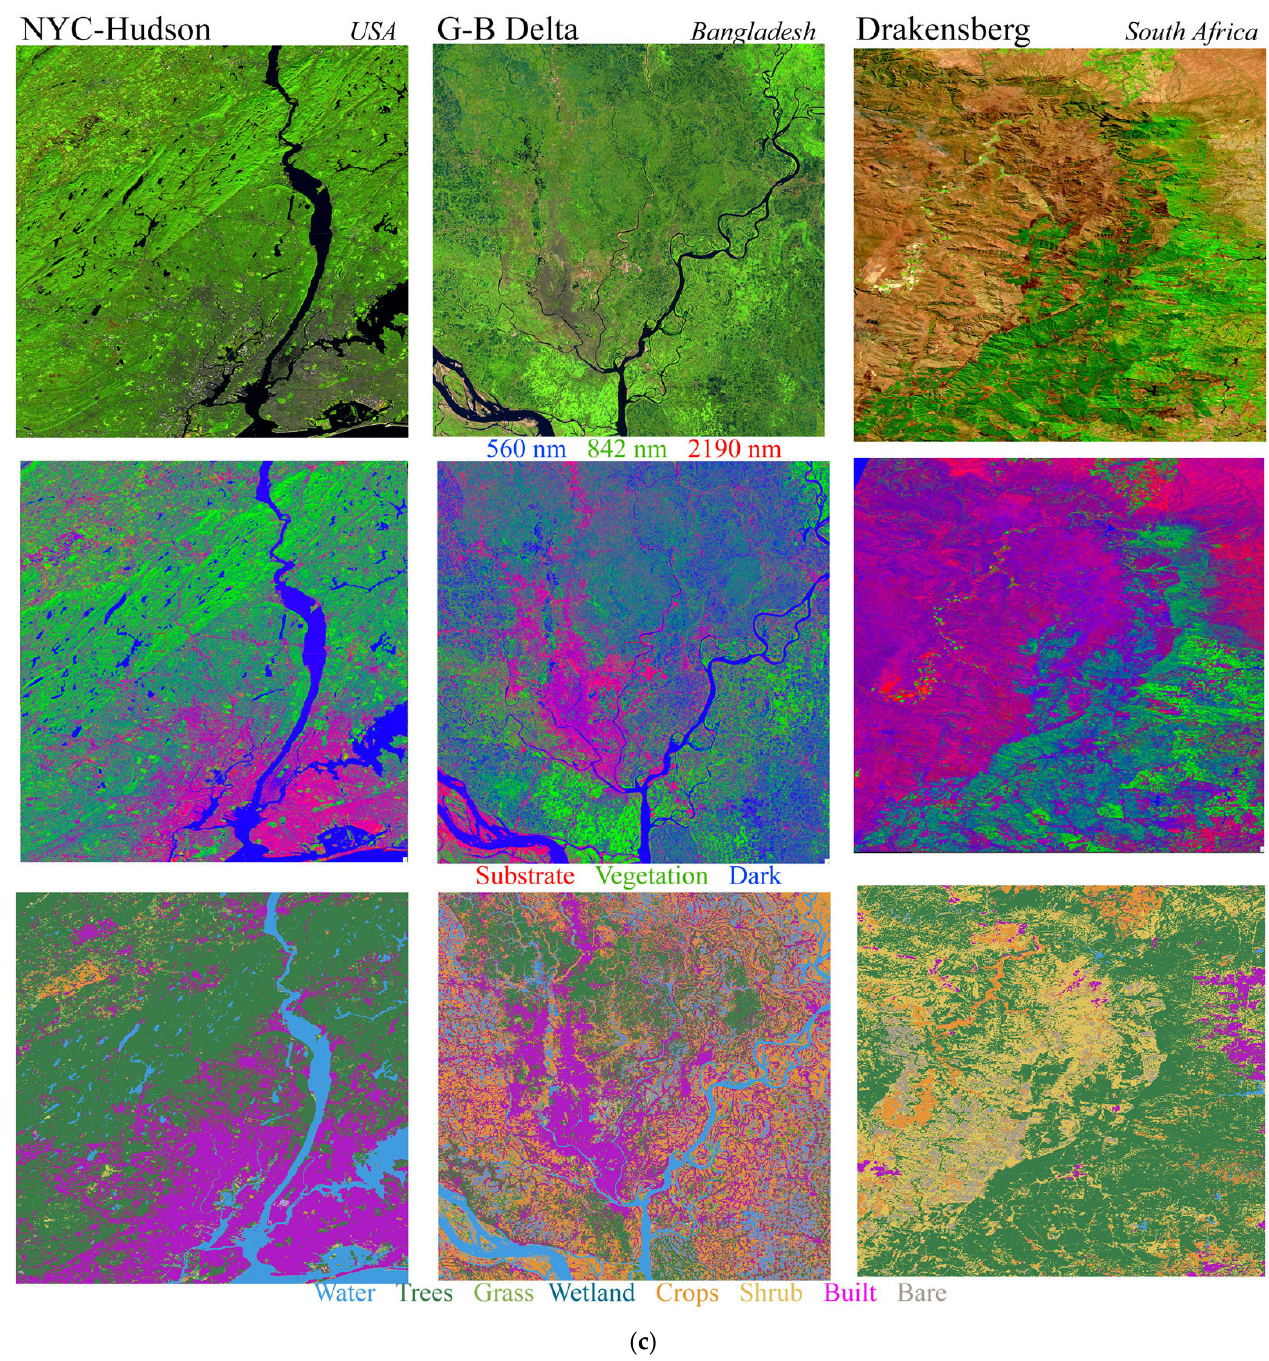
Figure 1. ( a ) Sentinel 2 reflectance, continuous land cover fraction, and Dynamic World land cover classification for three spectral diversity hotspots spanning multiple biomes and climatic zones. Reflectance (top) and land cover fraction (center) composites are each displayed with a 1% linear stretch. The land cover classification (bottom) shows the discrete class with the highest probability for each pixel. Each Sentinel 2 tile is 109.8 × 109.8 km. ( b ) Sentinel 2 reflectance, continuous land cover fraction, and Dynamic World land cover classification for three spectral diversity hotspots spanning multiple biomes and climatic zones. Reflectance (top) and land cover fraction (center) composites are each displayed with a 1% linear stretch. The land cover classification (bottom) shows the discrete class with the highest probability for each pixel. Each full Sentinel 2 tile is 109.8 × 109.8 km, but Mauna Kea-Kohala is 55 × 55 km and Western Ghats is 55 × 109.8 km, rescaled N-S. ( c ) Sentinel 2 reflectance, continuous land cover fraction, and Dynamic World land cover classification for three spectral diversity hotspots spanning multiple biomes and climatic zones. Reflectance (top)